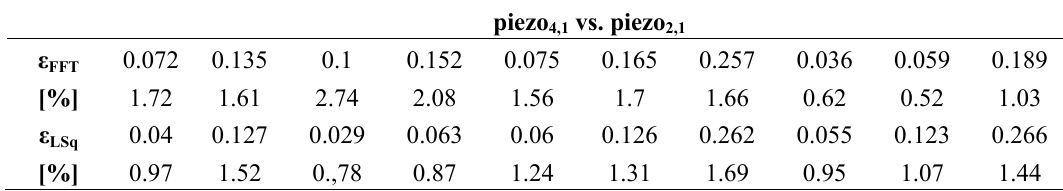
Figure 7. Frequency estimation errors per combination of grating and velocity, averaged over all experiments and window positions, versus the width of the observation